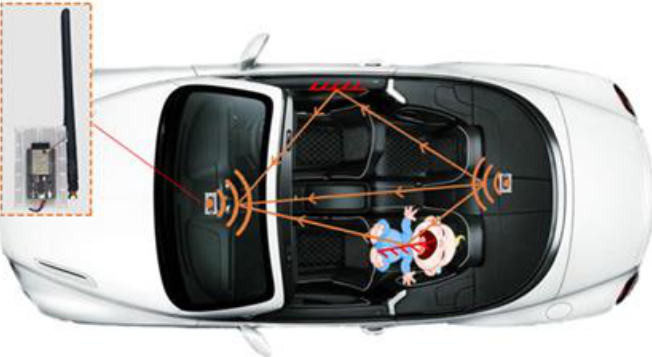
Figure 1. Car-Sense, ESP32-based contactless in-vehicle occupant sensing.